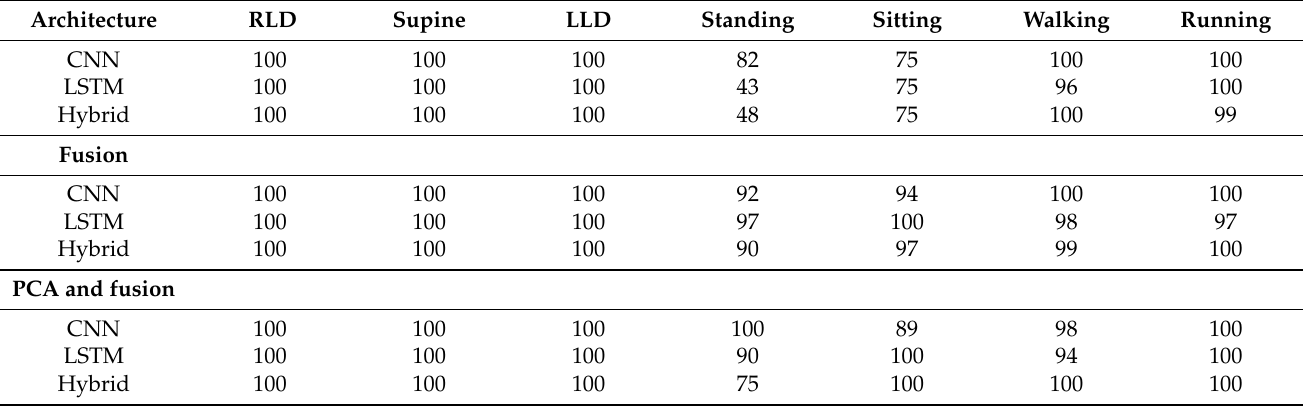
Figure 10. Performance of CNN network in activities classification. Left: without PCA applied and right: with PCA applied, which shows that the fusion of data significantly improve the network performance. Table 1. While the lying down related, static, and outdoor activities are better classified using accelerometer data, the data fusion with the sensors strip and PCA application have the added value of improving the classification